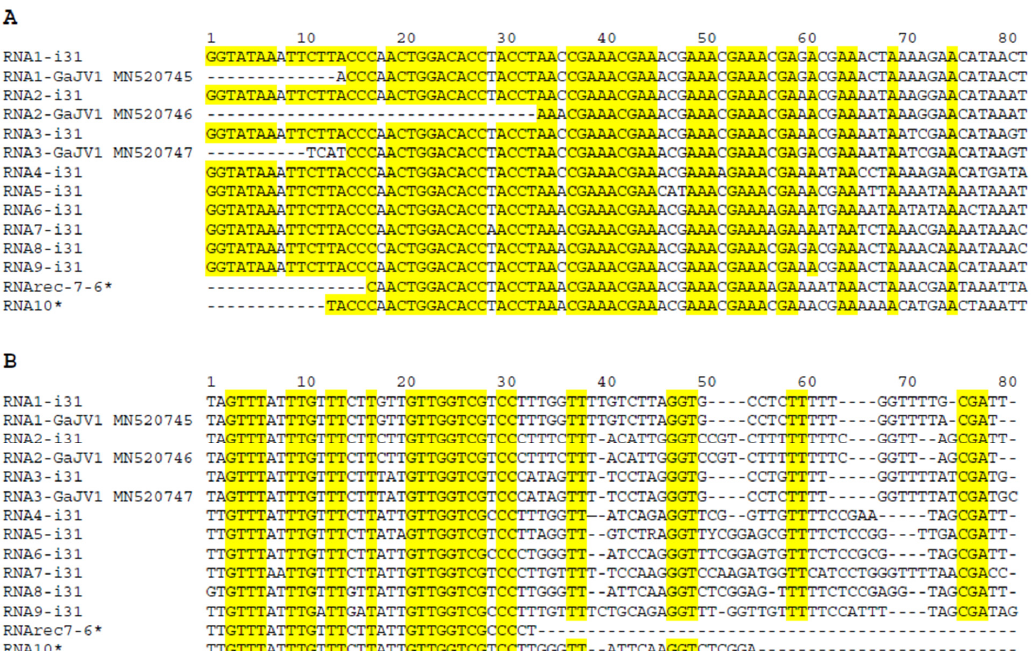
Figure 1. Multiple nucleotide sequence alignments of ( A ) the 5’ non coding region (NCR) and ( B ) the 3’ NCR of the various genomic segments identified for grapevine-associated jivivirus 1 (GaJV-1). The i31 isolate sequences determined here are shown, together with the RNArec 7-6 and RNA10 from the Teroldego isolate (marked by an asterisk) and with the RNA1, RNA2 and RNA3 sequences for the reference isolate (MN520745, MN520746, MN520747). Residues conserved in all RNA segments are highlighted in yellow.